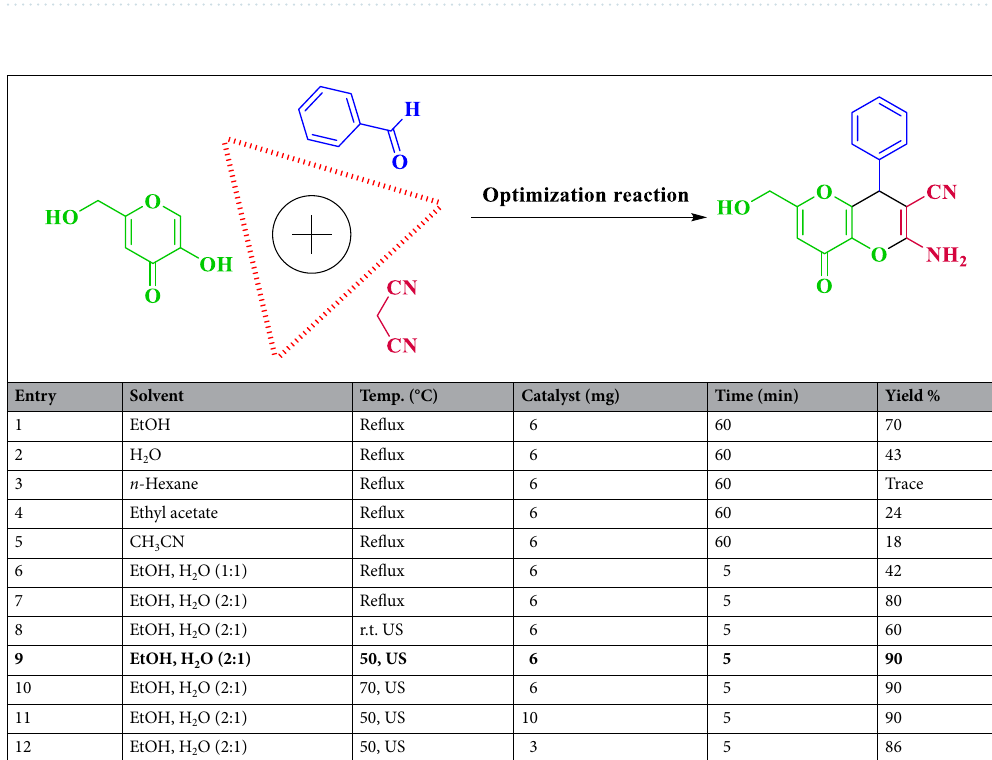
Table 1. Effect of different amounts of catalyst, temperature, ultrasonic and solvent (5 mL) in the synthesis of dihydropyrano[3,2- b ]pyran. Significant values are in